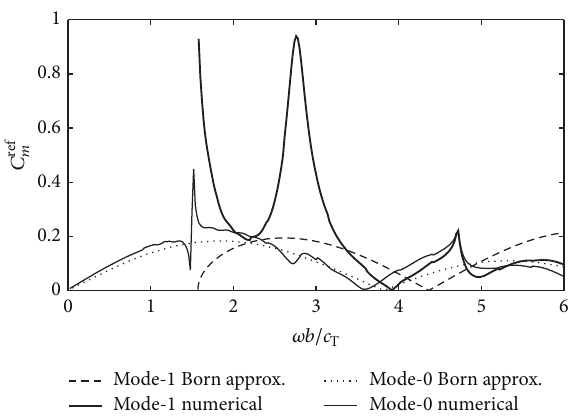
Mode- 1 Born approx. Mode- 1 numerical Figure 12: Reflection coefficients for 𝑅 1 = 0.5𝑏 , 𝑅 2 = 0.2𝑏 , and ̃𝑥 2 = −0.5𝑏